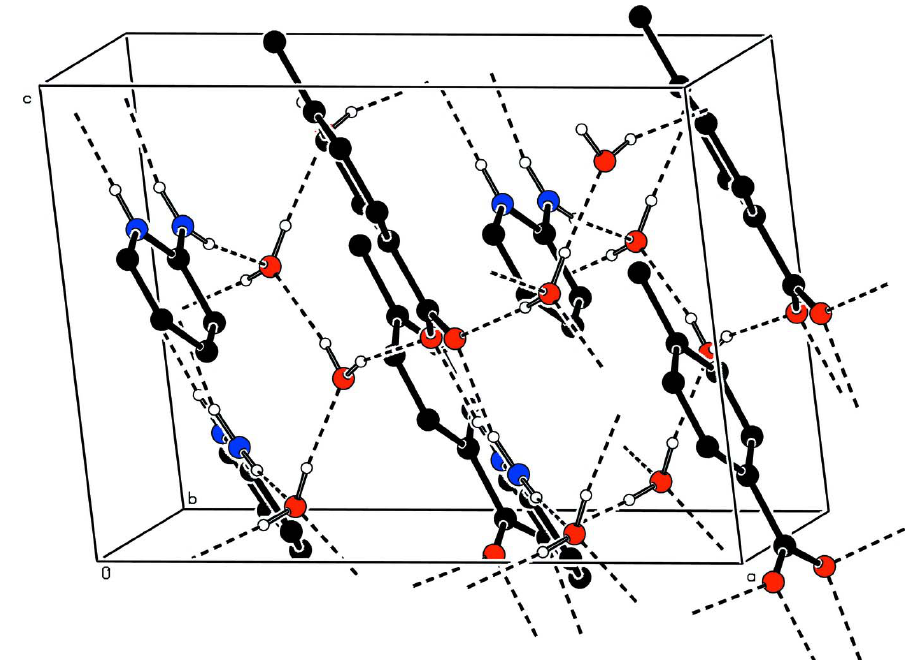
Figure 2 Three-dimensional structure of (I), with H bonds indicated by dashed lines. For clarity, H atoms not involved in hydrogen bonds are